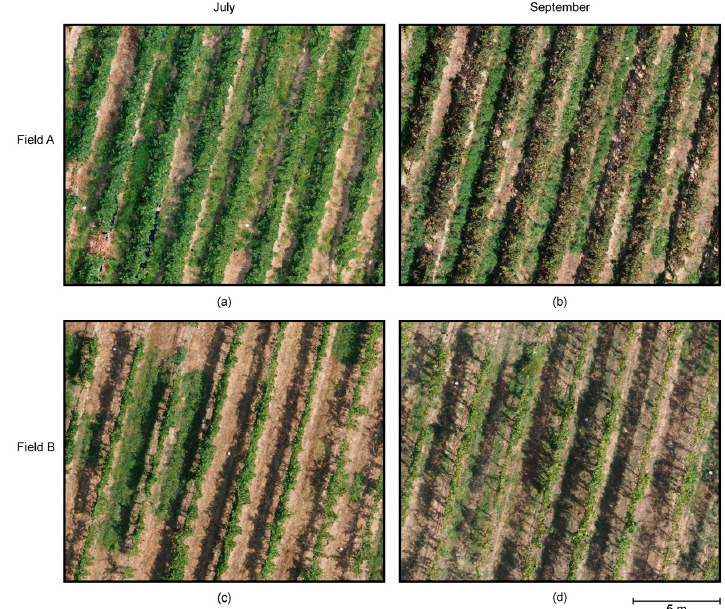
Figure 4. A partial top view of the point clouds generated from unmanned aerial vehicle (UAV) flights over fields A and B in the months of July and September: ( a ) Field A July, ( b ) Field A September, ( c ) Fueld B July and ( d ) Field B September.